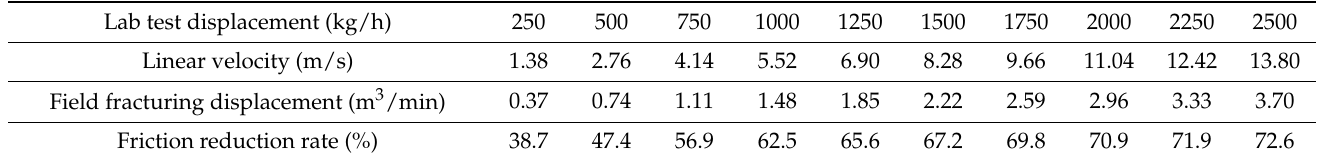
Table 7. Summary table of displacement, linear velocity, and friction reduction rate.